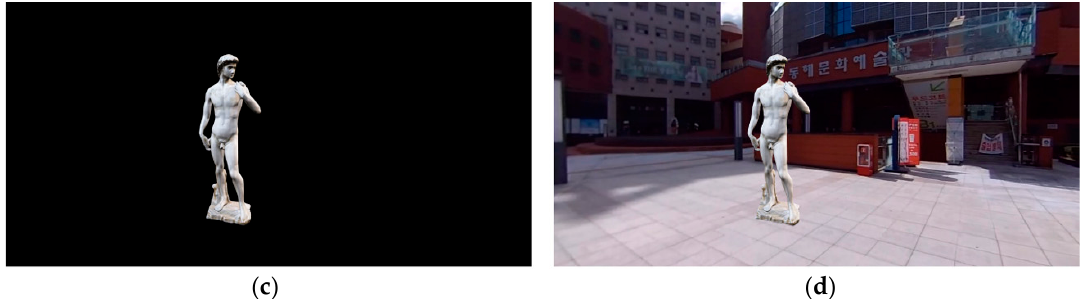
Figure 10. Rendered images and f inal 3D compositing images: ( a , b ) indoor and ( c , d ) outdoor.